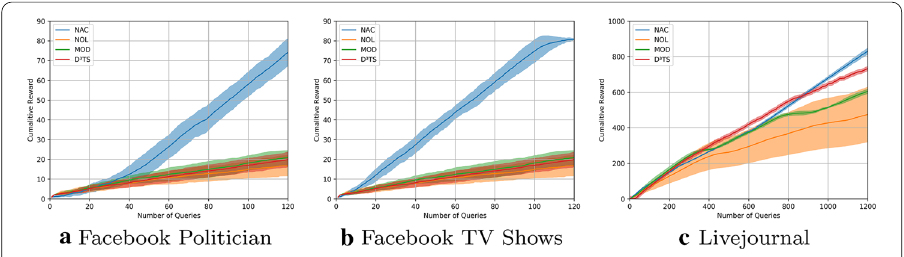
Fig. 5 NAC outperforms competitive online methods on real networks. For the Facebook networks ( a , b ), confidence bounds are estimated using 200 instantiations of the foreground network using 5 different parameter choices from Table 2 and varying the location where in the Facebook network we plant the foreground instance. For the Livejournal network ( c ), we pick 200 hundred different nodes in the foreground network, where the agent can start the